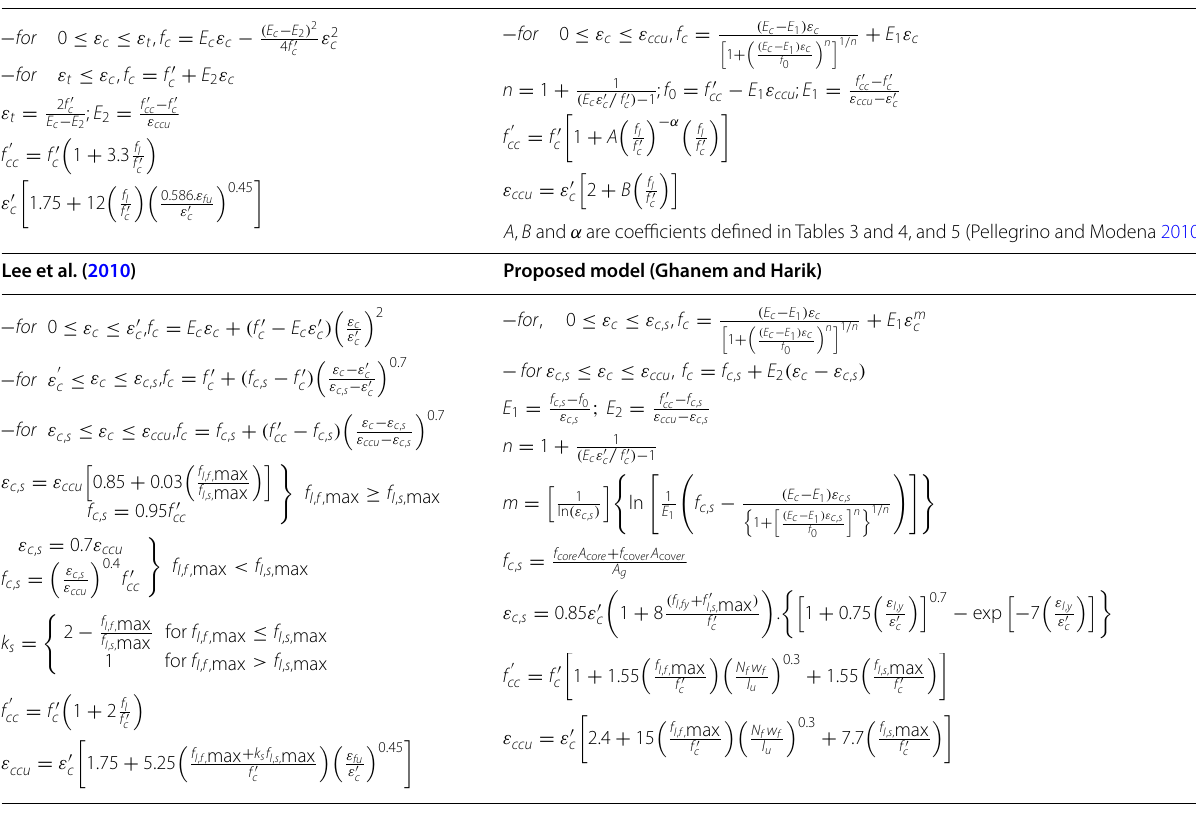
Table 4 Stress–strain models for FRP confined concrete. Lam and Teng (2003) Pellegrino and Modena